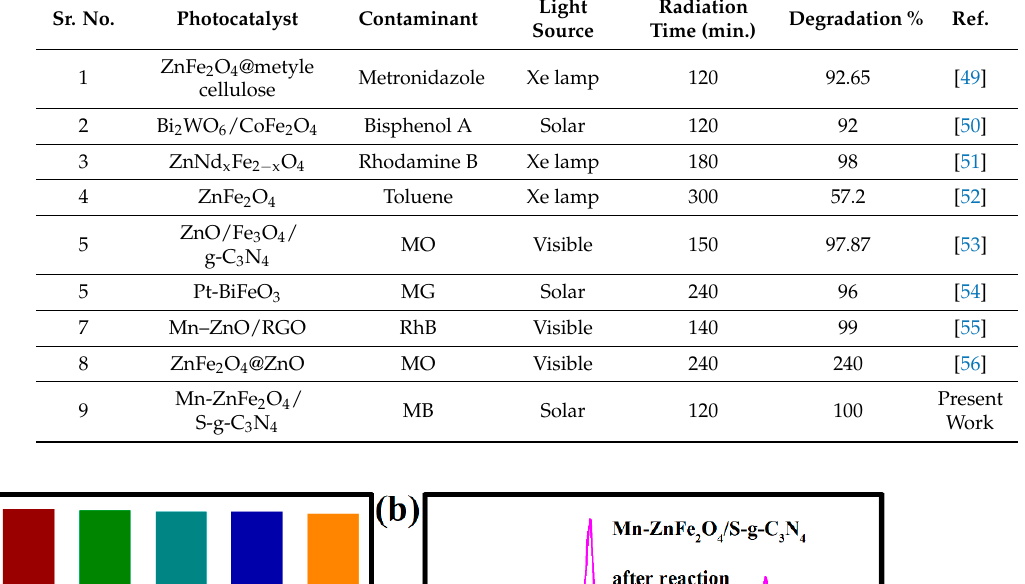
Table 3. Comparison of photocatalytic efficiency of the Mn-ZnFe 2 O 4 /S-g-C 3 N 4 NCs with some previous works.